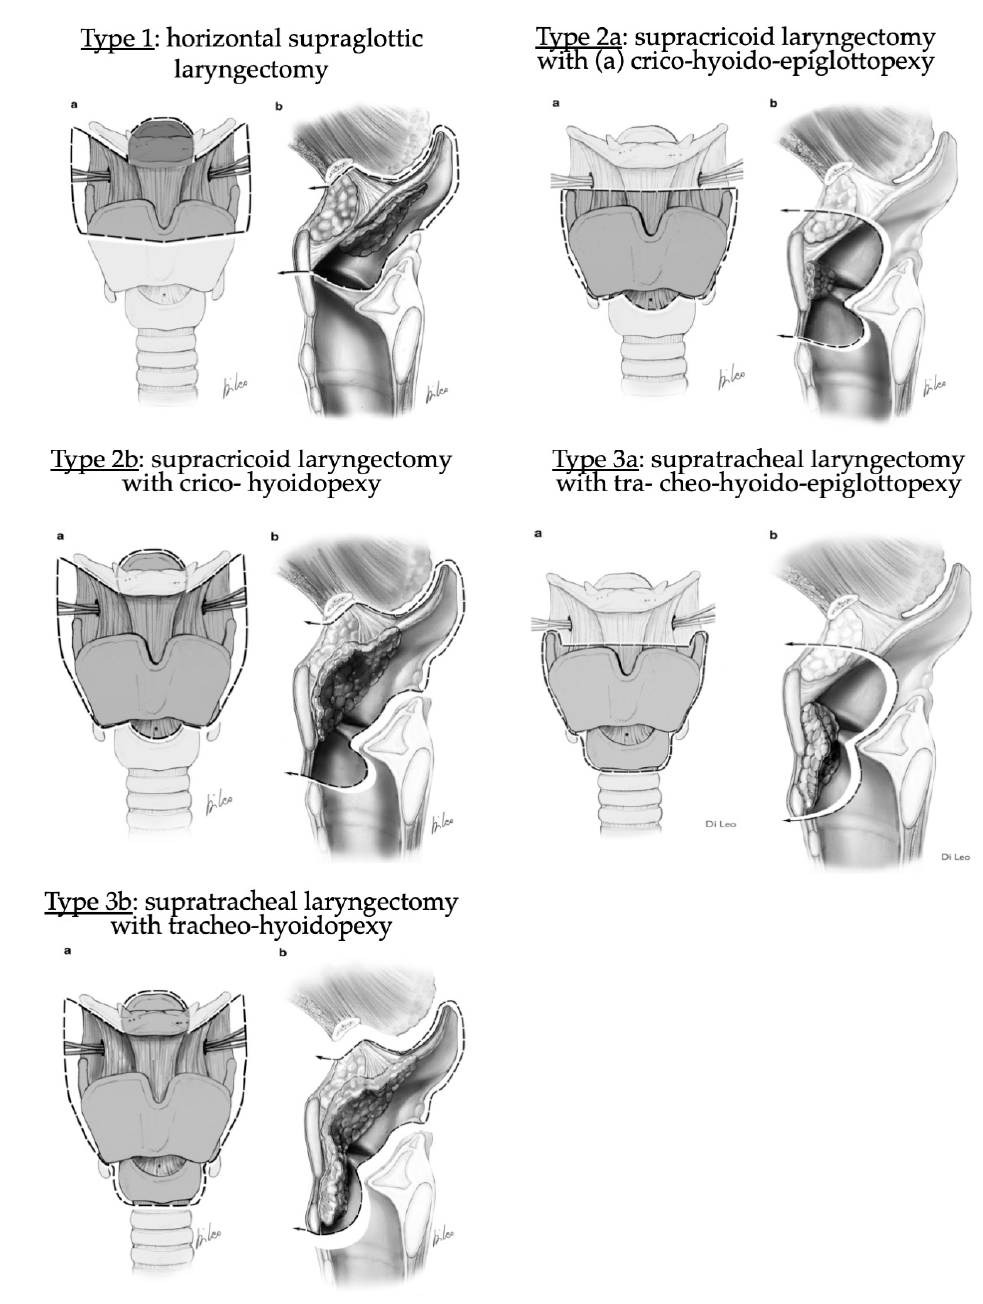
Figure A1. European Laryngological Society Classification of Partial Laryngectomy. a = coronal plan, b = saggital plan.